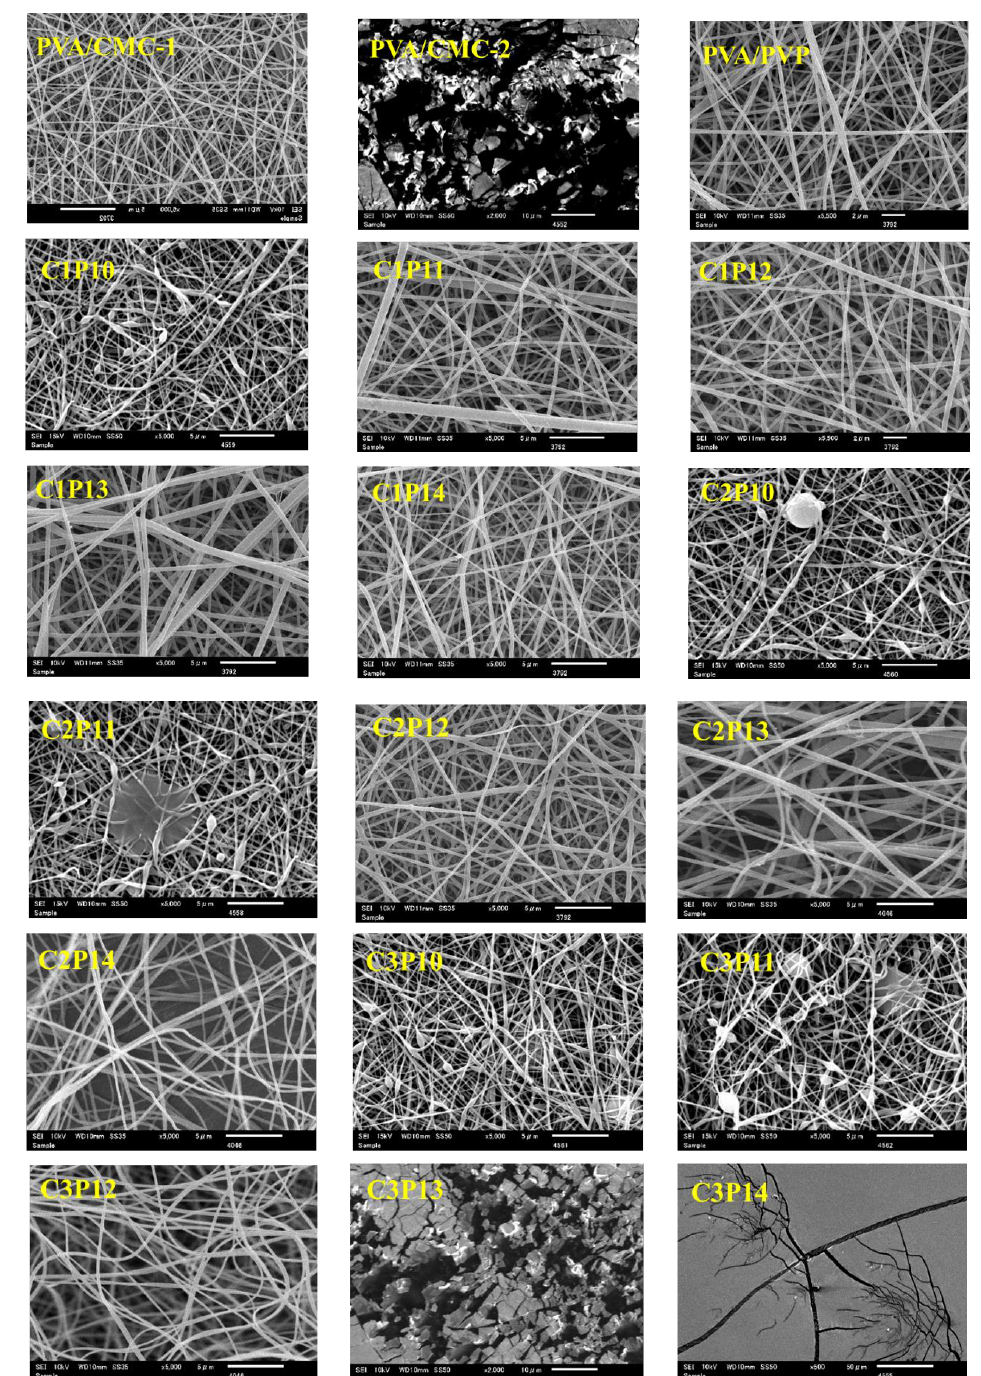
Figure 2. SEM images of PVA/CMC (PVA/CMC 1–2), PVA/PVP, and PVA/PVP/CMC (C1P10–C3P14) composite nanofibers: Effect of variation of concentration of PVP and CMC on morphology of nanofibrous mats .